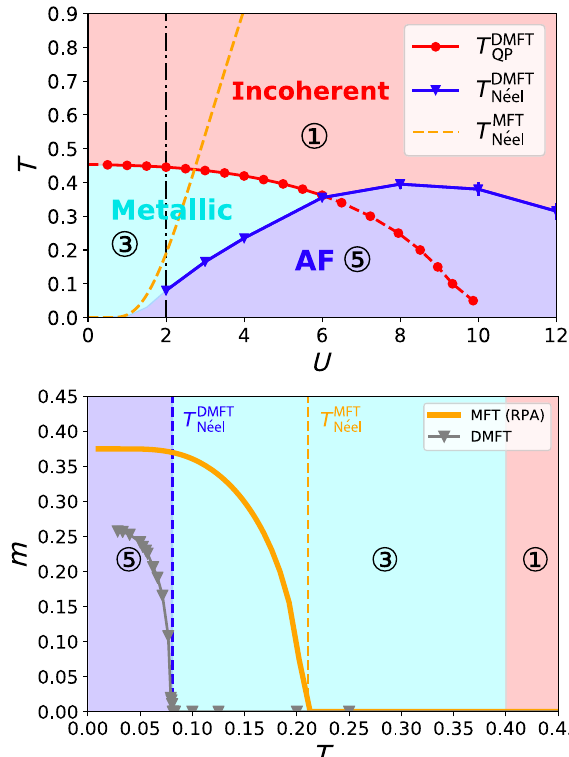
FIG. 6. Upper panel: phase diagram of the half-filled Hubbard model on a square lattice as a function of U within DMFT. The dotted dashed line marks U ¼ 2 . Lower panel: magnetization at U ¼ 2 as a function of T calculated in (symmetry-broken) DMFT (dark-gray curve) and MFT (orange